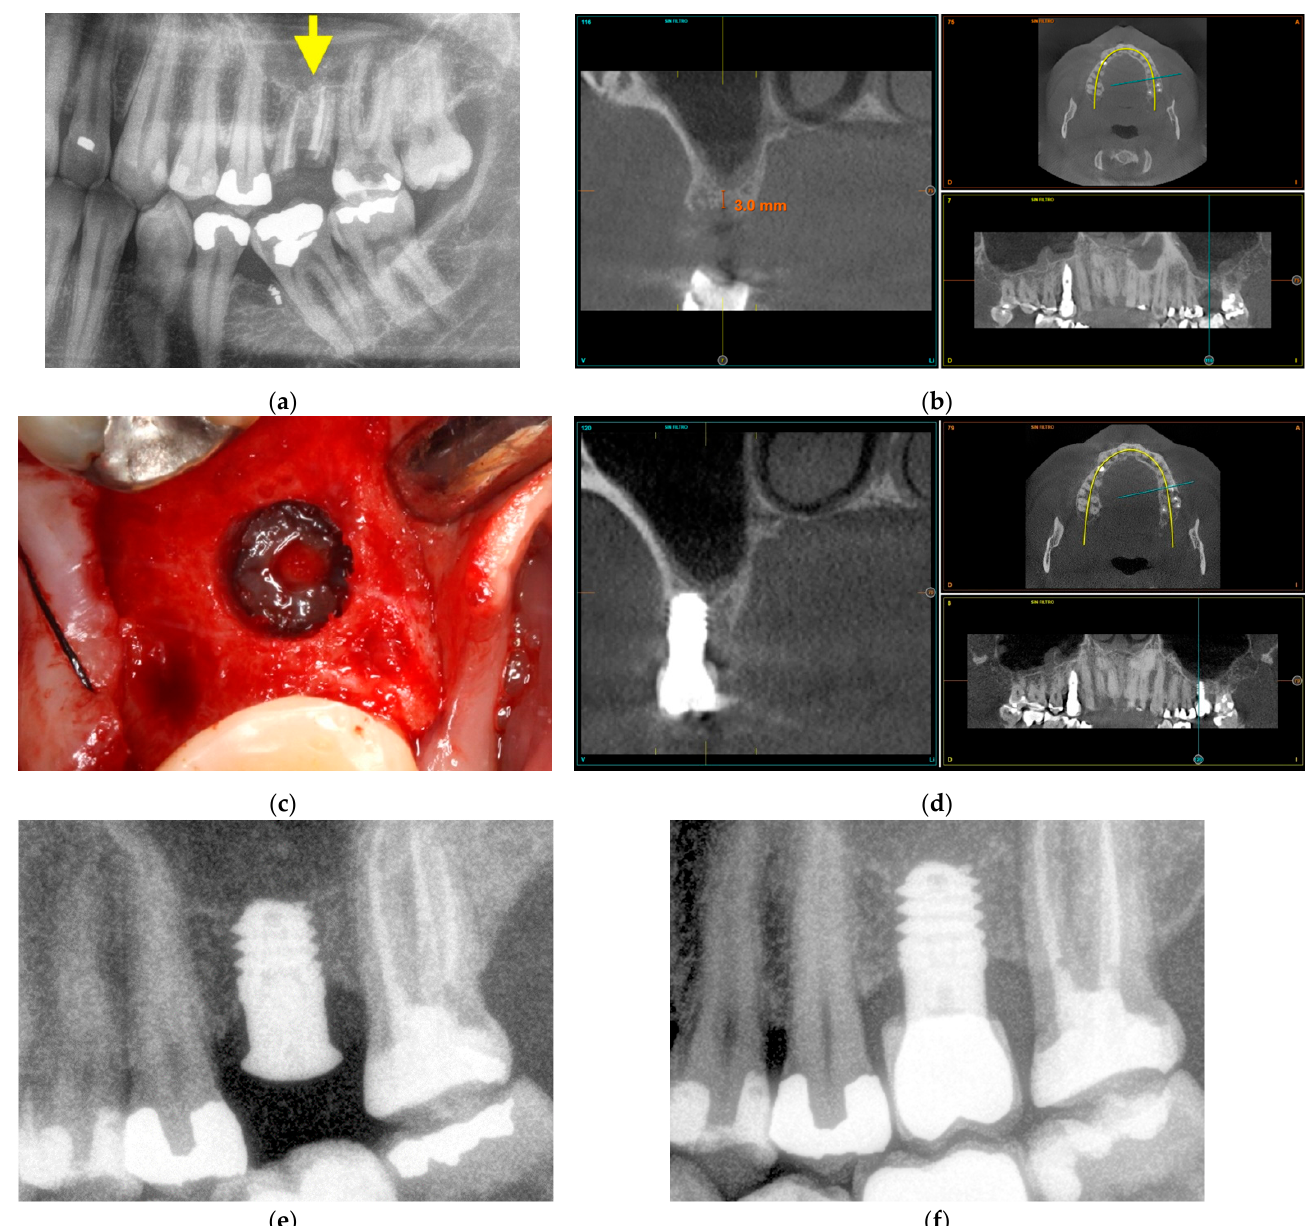
Figure 8. Maxillary sinus floor augmentation. Prior extraction of the infected tooth roots, marked with a yellow arrow ( a ). Three months after extraction, the residual bone height is 3 mm ( b ). The sinus membrane was gently pushed upwards with autologous bone recovered from the site preparation mixed with PRGF-Endoret ® ( c ). A 5.5 mm short implant is placed at the implant site to support the sinus floor elevation apically ( d ). Three months after implant placement, the bone height around the implant was 4.5 mm ( e ). Five years after the placement of a short implant, the measured bone height at the implant site was 7.5 mm ( f ).